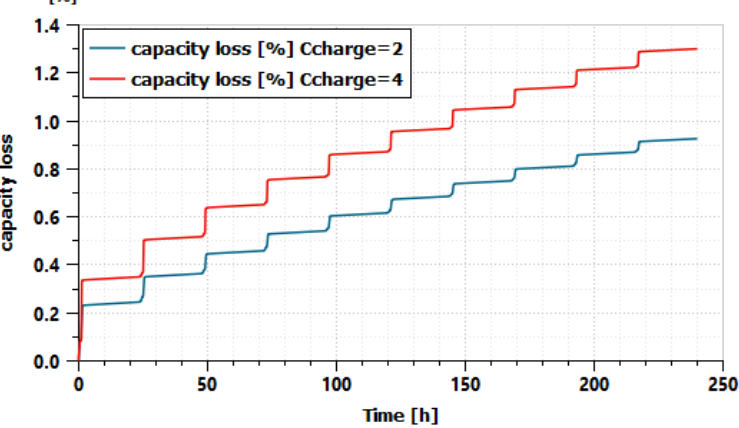
Figure 12. Simulated capacity loss for scenarios with two different charging current (2C or 4C) using the air cooled 12S2P stack model.